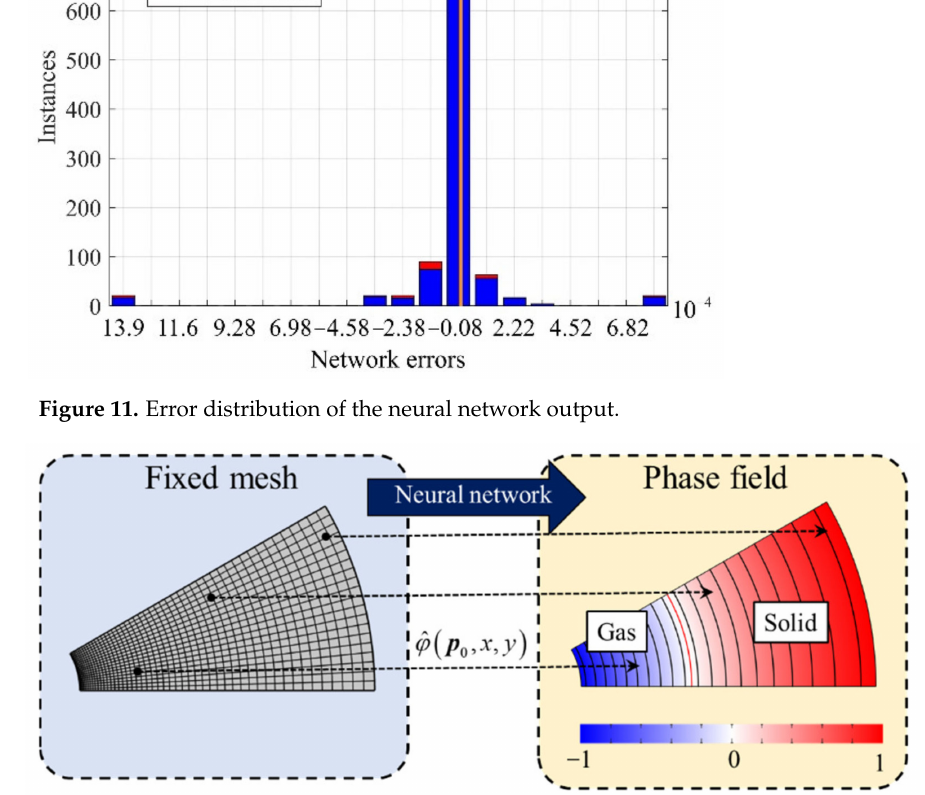
Figure 12. Mapped phase field of the tube grain using the pre-training neural network. As shown in Figure 10, the MSE decreases monotonically with the training